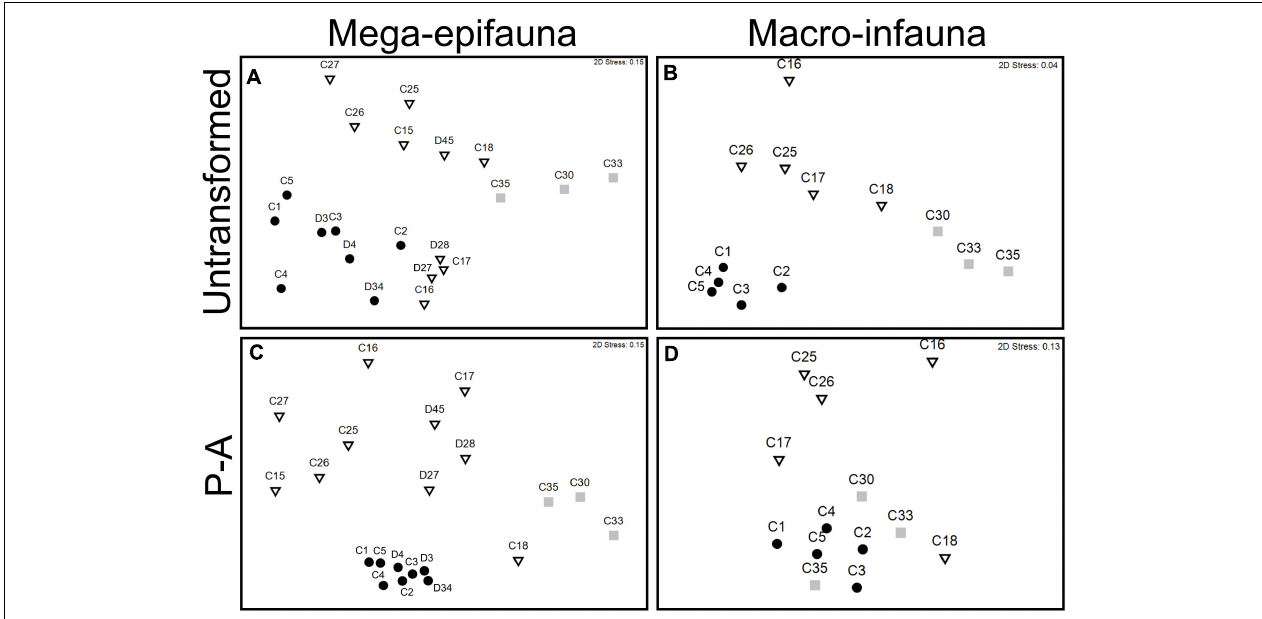
FIGURE 5 | MDS ordinations of mega-epifaunal and macro-infaunal community similarity between sampling sites on the continental shelf (circles), continental slope (triangles), and abyss (squares). Data are untransformed ( A,B ), and presence-absence transformed (P-A, C,D ) abundance values from seabed video transects (mega-epifauna) and multicorer (macro-infauna) samples. Distances represent Bray – Curtis similarities among sites.